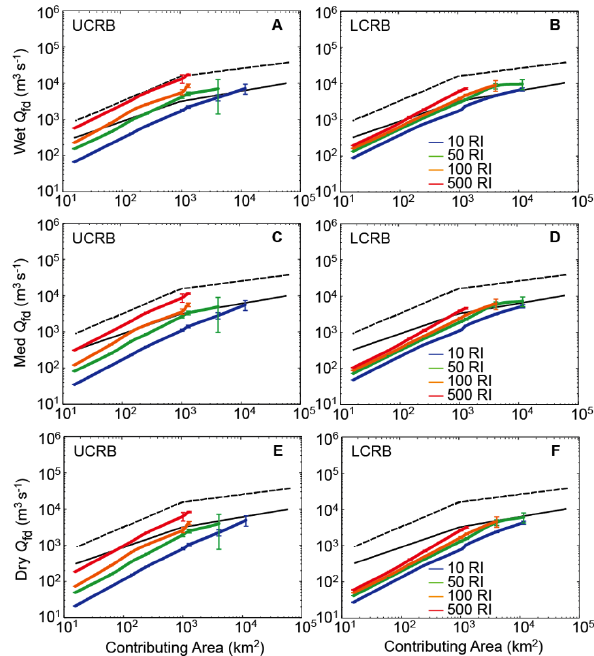
Figure 7. Q fd frequency–magnitude–area curves of 10, 50, 100, and 500-year recurrence intervals (RIs) and for wet, medium, and dry conditions for the Upper Colorado River Basin (UCRB) and the Lower Colorado River Basin (LCRB). Published FECs (black lines) for the Lower Colorado River Basin (solid black line) from Enzel et al. (1993) and the US (dashed black line) from Costa (1987) are also